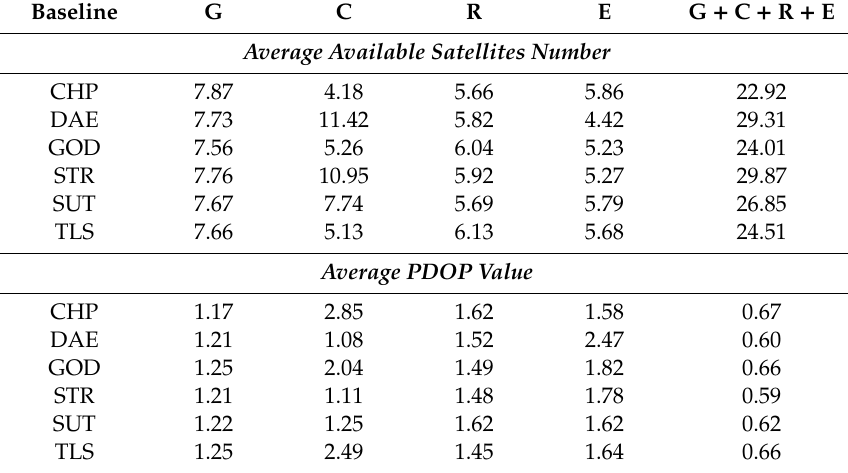
Table 3. Average common satellite number and positioning dilution of precision (PDOP) values of di ff erent